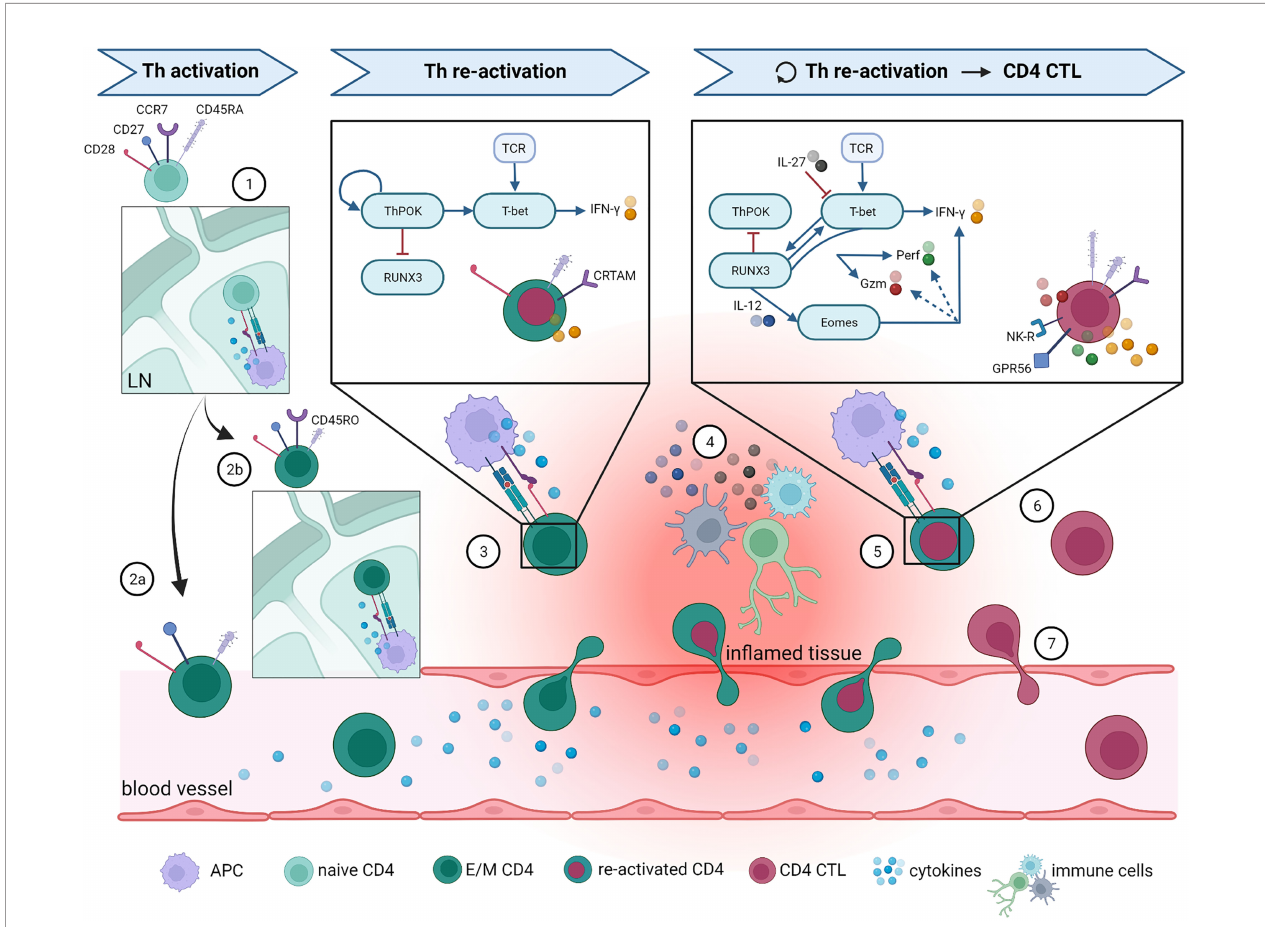
FIGURE 1 | Overview of proposed CD4 CTL development pathway and phenotype. The most important steps in Th and CD4 CTL differentiation are illustrated here. (1) Naïve CD4 + T cells enter lymph nodes (LN) and are activated upon binding to their cognate antigen. Following this activations, naïve cells either differentiate into (2a) effector Th cells that can directly migrate towards the site of in fl ammation, or into (2b) central memory Th cells that can quickly expand upon repeated infection. After re-activation in LN, central memory Th cells can also differentiate into effector Th cells and migrate towards in fl amed tissue. (3) At the site of in fl